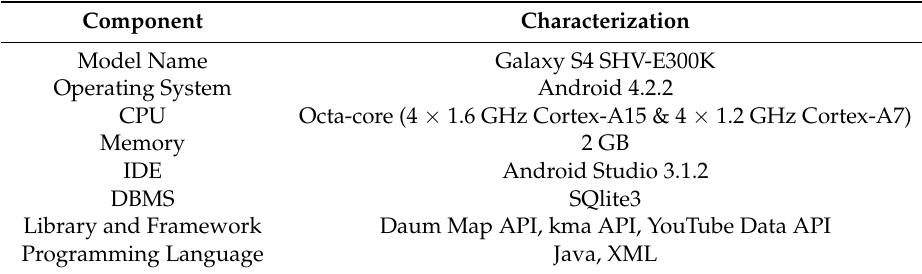
Table 7. Development stack of the mobile tourist